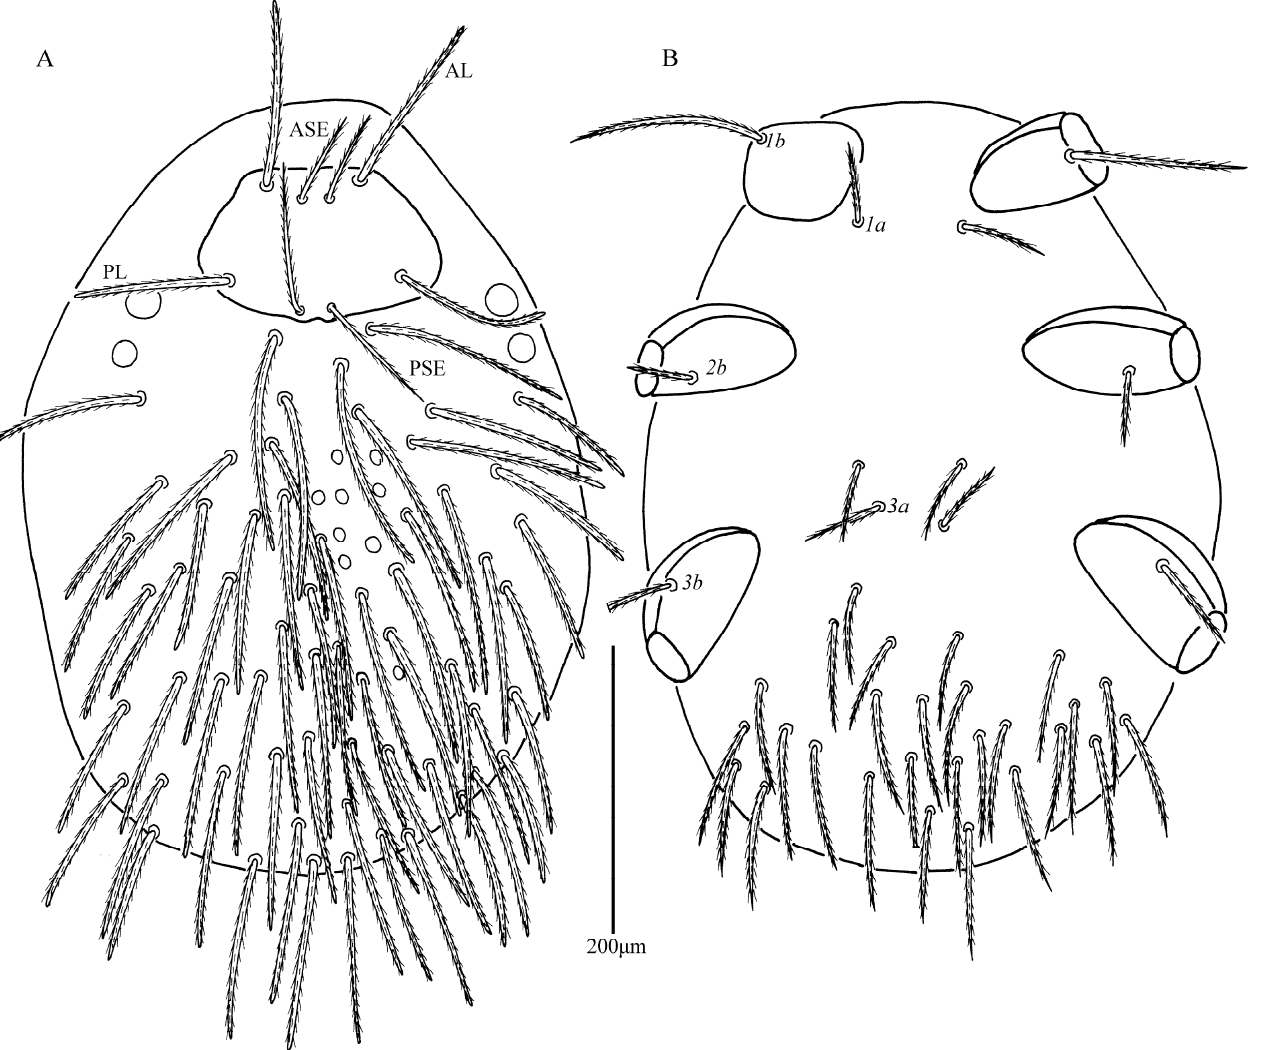
Figure 1. Eatoniana nanlingensis sp. nov. , larva. ( A ). Dorsal view of idiosoma. ( B ). Ventral view of idiosoma.